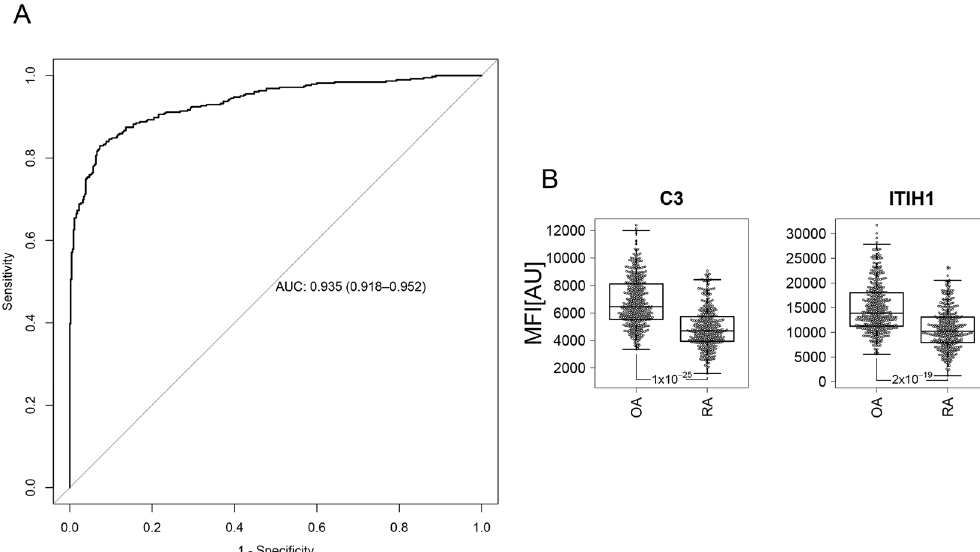
Figure 5. ( A ) ROC curve demonstrating the classification power of the panel of 30 proteins identified in this study for the classification between all OA patients and RA individuals included in the study. ( B ) Box-plots showing the two proteins revealing significant differences between OA patients and controls, which also revealed significant differences (P < 0.05) between OA and RA patients. For each sample group, the box-and- whisker plot represents MFI values within lower and upper quantile (box), the median (horizontal line within box), percentiles of 5% and 95% (whiskers) and outliers